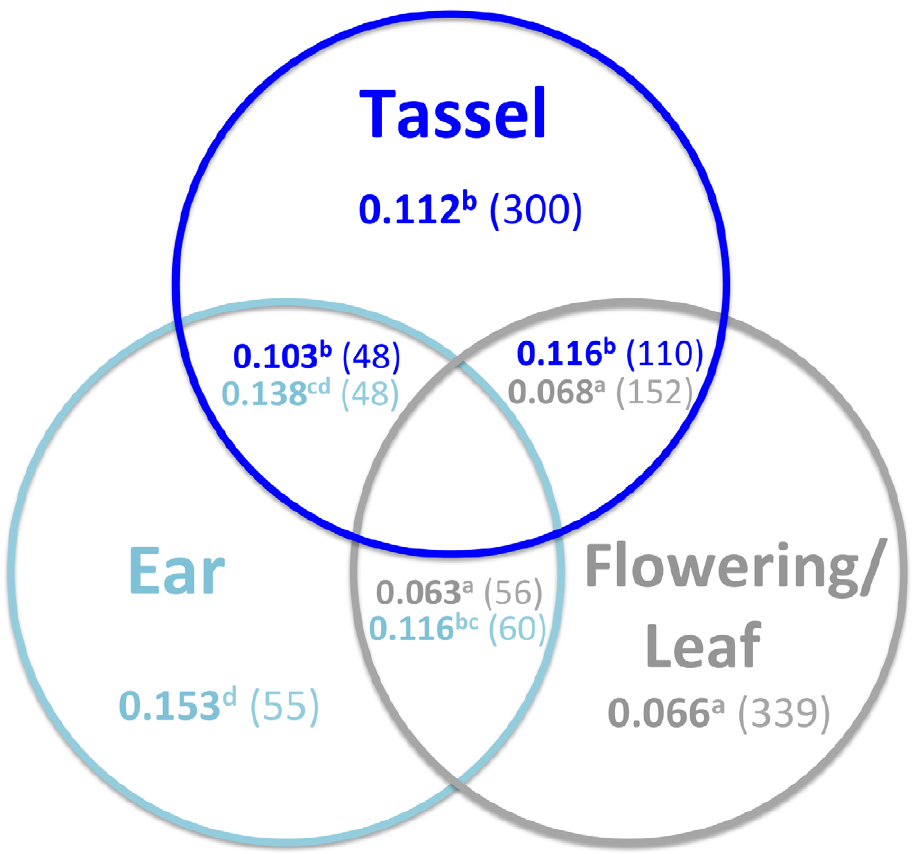
Figure 6. Relationship between QTL pleiotropy and effects. Mean effects (in bold) and SNP number (in parentheses) are shown for GWAS SNPs in sliding windows that show significant pleiotropy within and between trait categories. For simplicity, flowering and leaf traits are combined into a single category. Only pleiotropic SNPs are considered. Non-overlapping areas within circles represent instances of pleiotropy within a trait category (for example, pleiotropy between two tassel traits). In cases of pleiotropy between trait categories (overlap between colored circles), color is used to distinguish the mean effects and SNP numbers for the different trait categories. For example, in sliding windows in which significant pleiotropy is observed between tassel and ear traits, the 48 relevant tassel SNPs have a mean effect size of 0.103, whereas the 48 relevant ear SNPs have a mean effect size of 0.138. Superscripted letters indicate which effect distributions differ significantly from each other (Kolmogorov-Smirnov test p -value , 0.05). Only the top 200 GWAS SNPs for each trait were included in the analysis, ordered by decreasing RMIP.